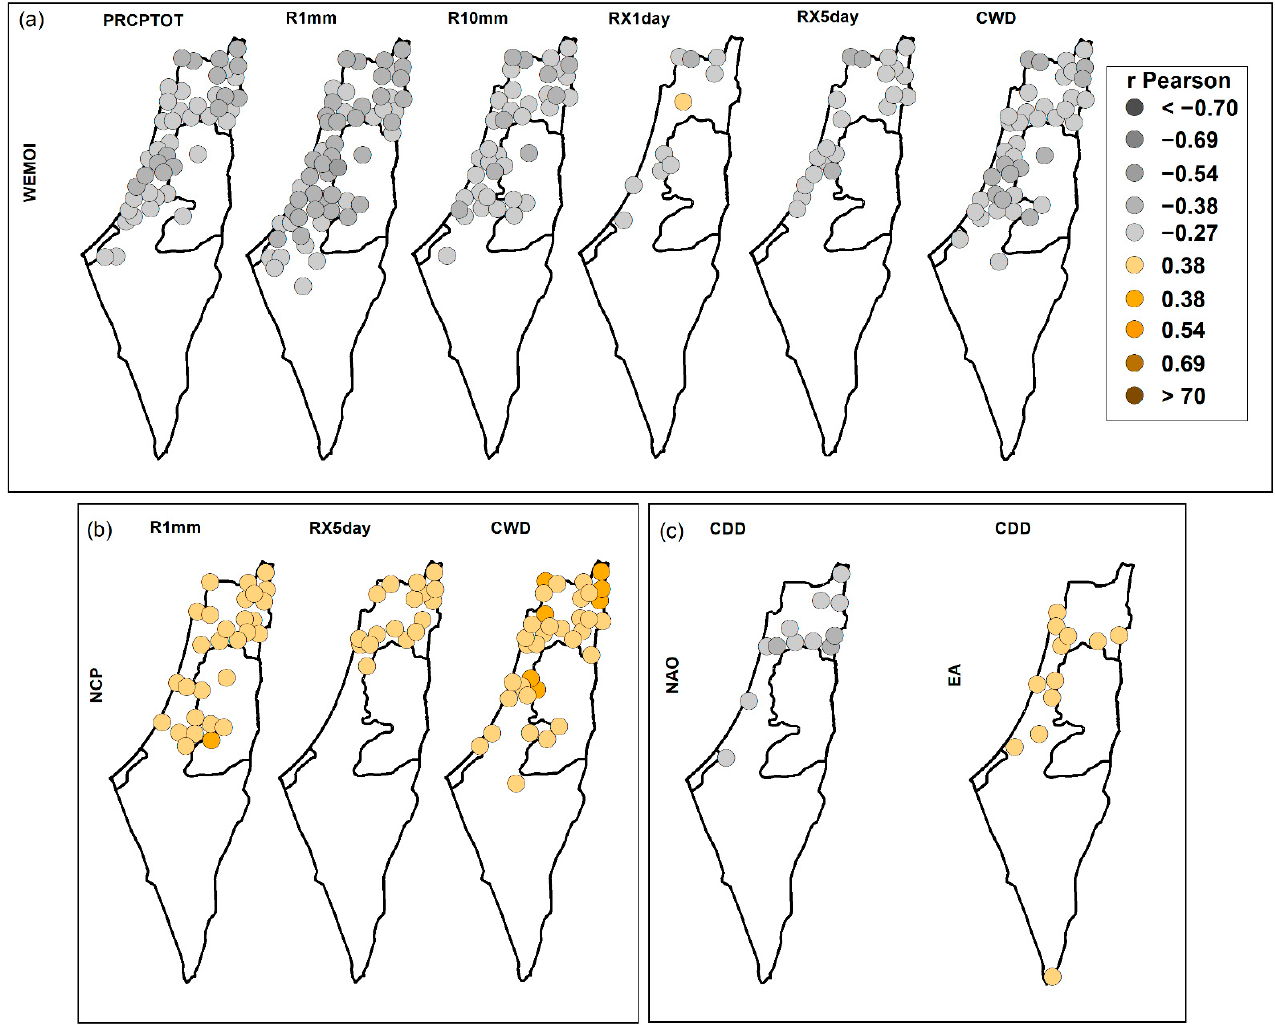
Figure 8. Spatial distribution of significant Pearson correlation coefficients between the teleconnection indices (WEMOI, NCP, NAO, and EA) and the extreme precipitation indices (PRCPTOT, R1mm, R10mm, RX1 day, RX5 day, CWD, and CDD), in spring.